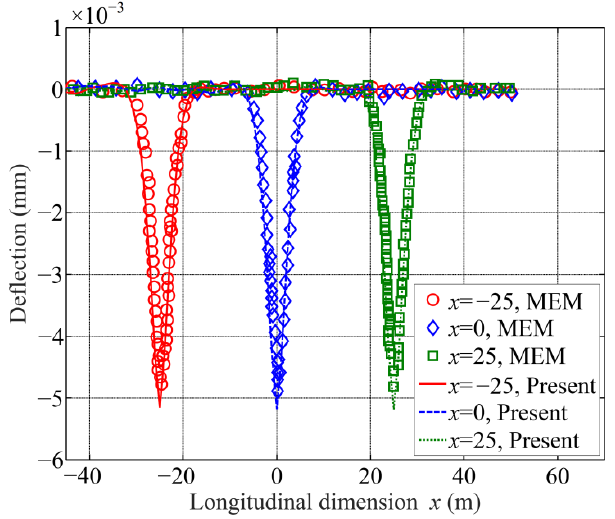
Figure 3. Comparison of the plate’s deflection obtained by the meshfree RPIM and the MEM [34] at three different time instances.